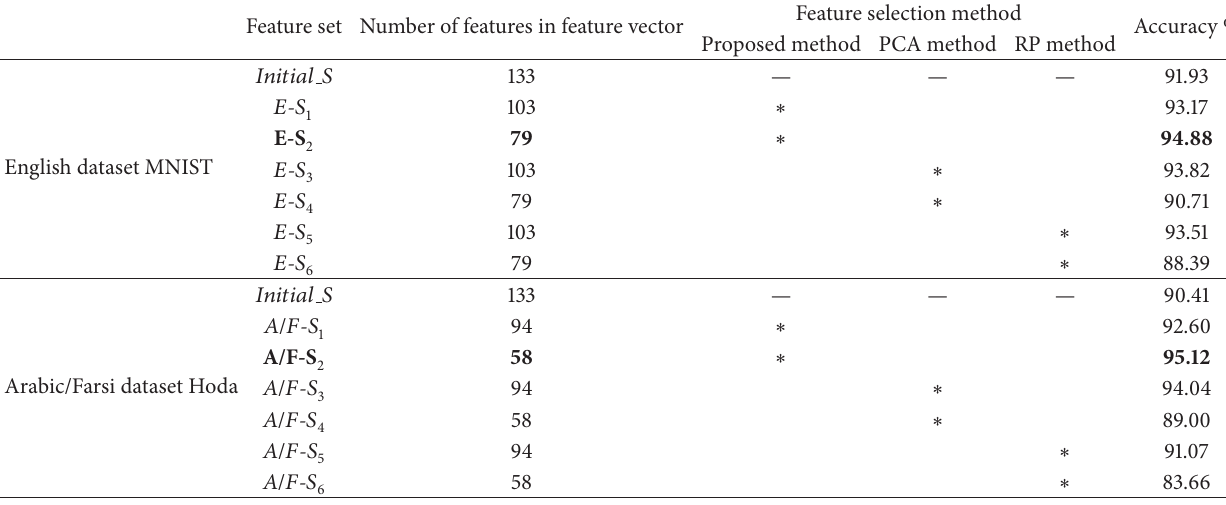
Table 4: Recognition rate corresponding to different feature vectors for the English dataset MNIST and Arabic/Farsi dataset Hoda. Feature set Number of features in feature vector